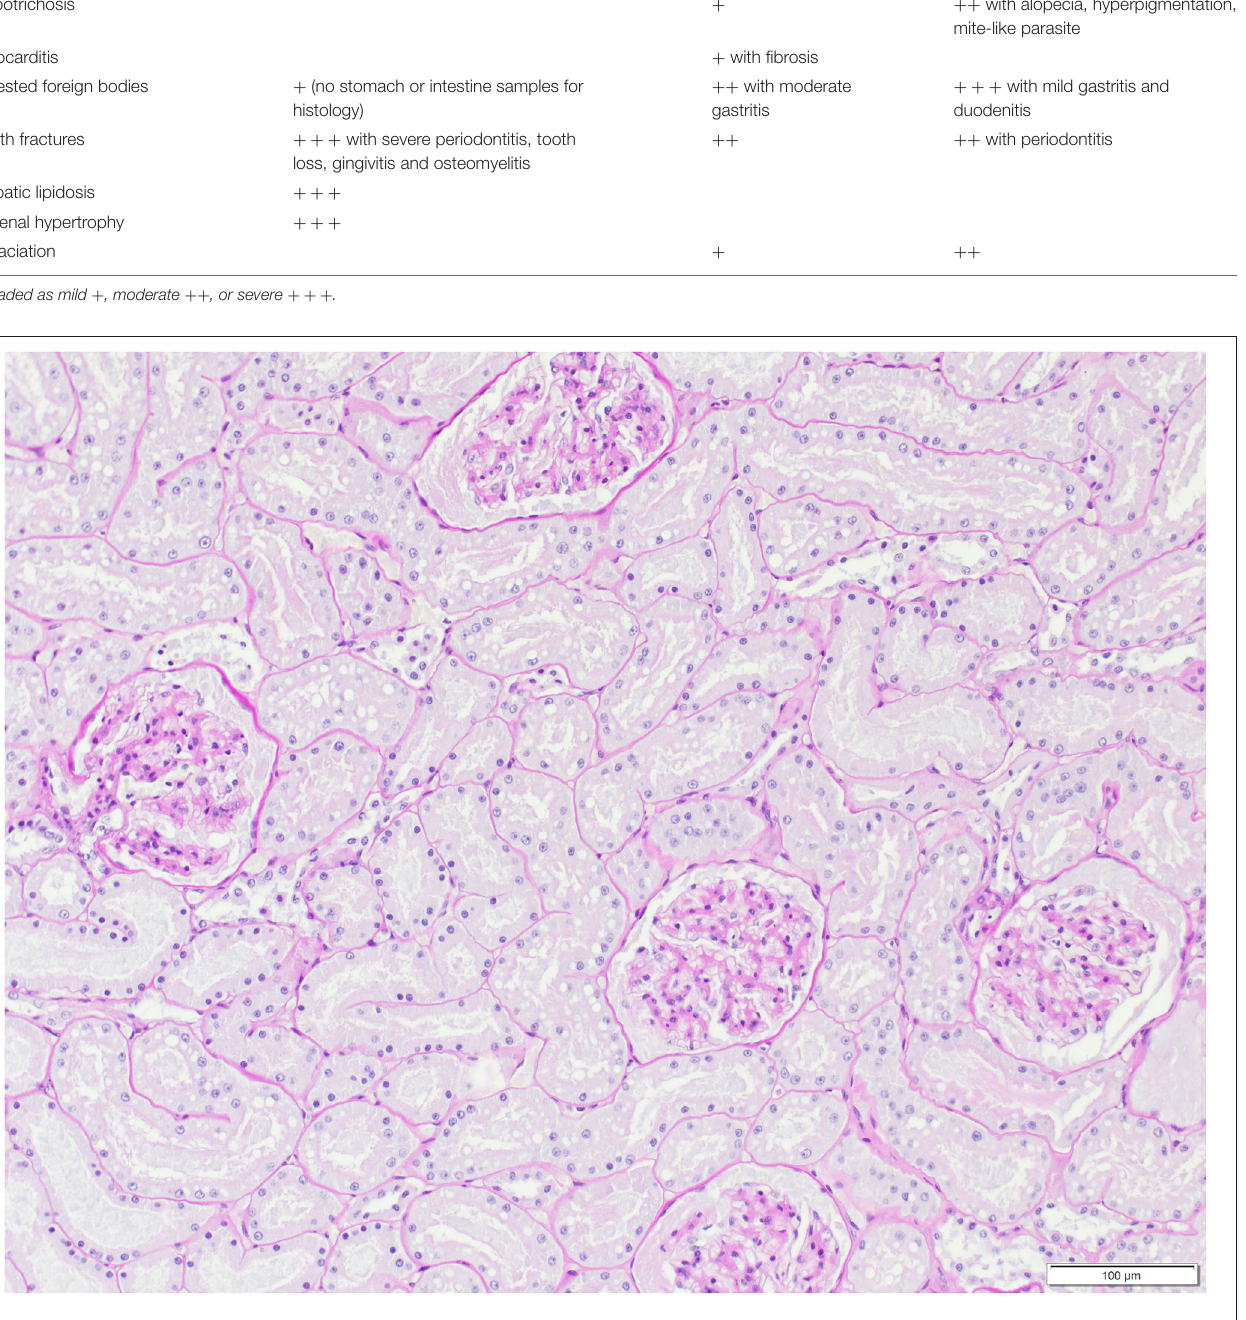
Frontiers in Veterinary Science |